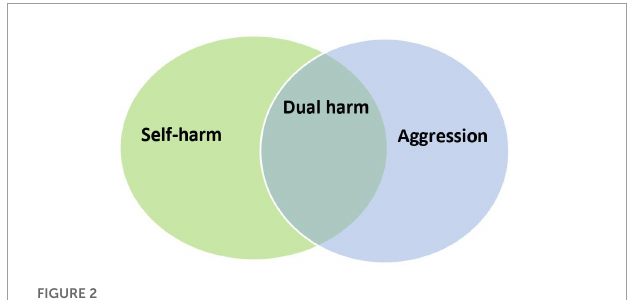
FIGURE2 Dual harm as an overlap between self-harm and